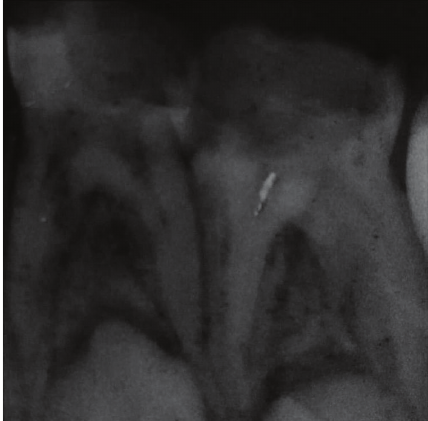
Figure 1: Preoperative radiograph showing advanced dental caries in left mandibular first and second molars.